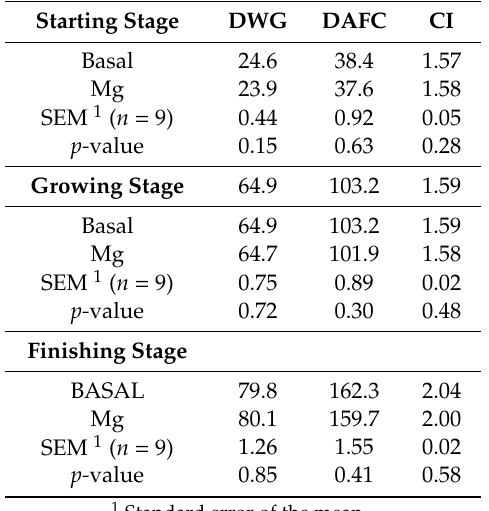
Table 2. E ff ect of the dietary treatment on the daily weight gain (DWG, g / d); daily average feed consumption (DAFC, g / d) and the conversion index (CI, g / g) of the broilers. Starting Stage DWG DAFC CI Basal 24.6 38.4 1.57 Mg 23.9 37.6 1.58 SEM 1 ( n = 9) 0.44 0.92 0.05 p- value 0.15 0.28 Growing Stage 64.9